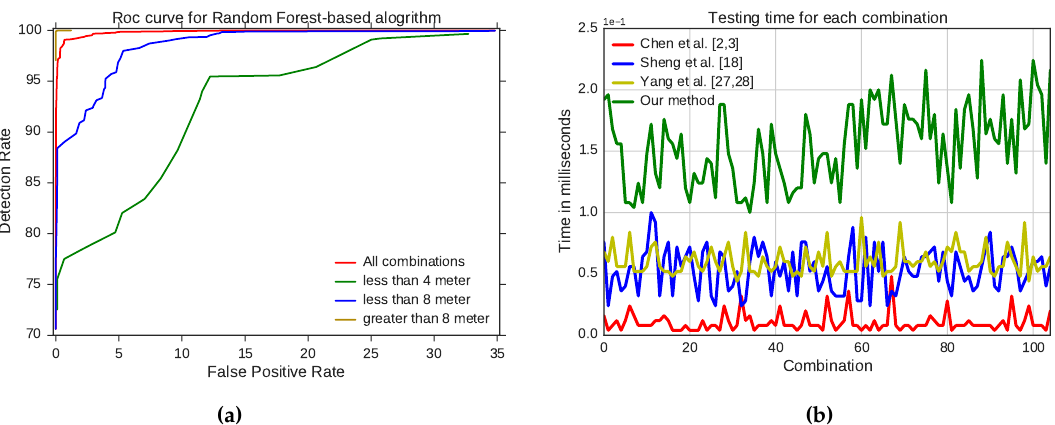
Figure 5. ROC curve of the proposed method and testing time of all of the methods. ( a ) ROC curve for the proposed method; ( b ) testing time for 10,000 samples for the tested methods. Table 2. Testing time for all location